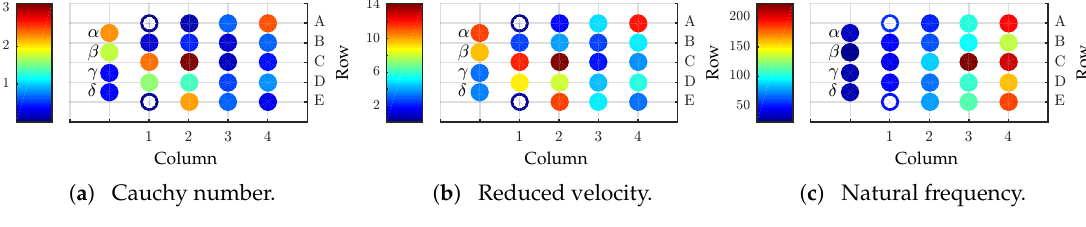
Figure 2. ( a ) Cauchy number and ( b ) reduced velocity in modified form from [29]. ( c ) Natural frequency of the vibrissae across the mystacial pad. ( a , b ) consider the same parameters as in Figure 1. Annulus markers correspond to inaccurate